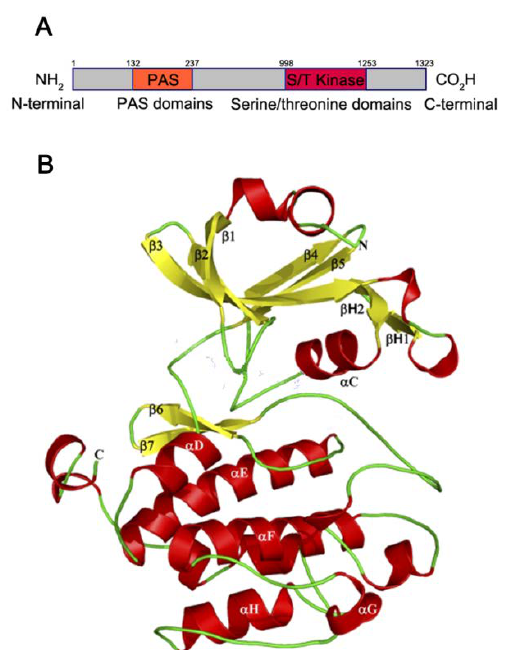
Figure 1. ( A ) Schematic diagram of the domain architecture of Per-Arnt-Sim Kinase (PASK). PASK usually contains a Per-Arnt-Sim (PAS) domain (orange square) and kinase domain (red square). The N -terminus of the PAS domain is described as “NH 2 ” while the C -terminus of kinase domain is indicated to be “CO 2 H”.( B ) The crystal structure of the PAS domain of PASK. The structure of PAS domain of PASK is usually an α/β helix, that is folded with several α helices depicted in red and surrounded by a five-stranded antiparallel β-sheets in yellow, composing a structurally-conserved core. The loops are shown in green (Fα/FG loop), and the N and C termini of the kinase structure are indicated as N and C [22].